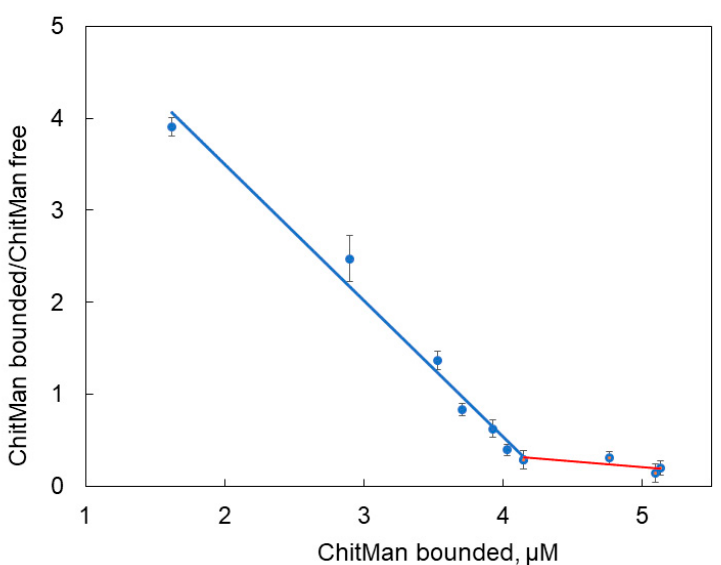
Figure 7. Linearization of the sorption isotherms of the complex of DPPC:CL 80:20 (weight %) liposomes with ChitMan (BME 5) in Scatchard coordinates. SD, n = 3. 0.02 M Na-phosphate buffer solution, pH 7.4, 22 °C. ConA concentration 5.4 mg/mL. The concentration of the Ca 2+ and Mn 2+ ions is 3.6 × 10 − 5 M.